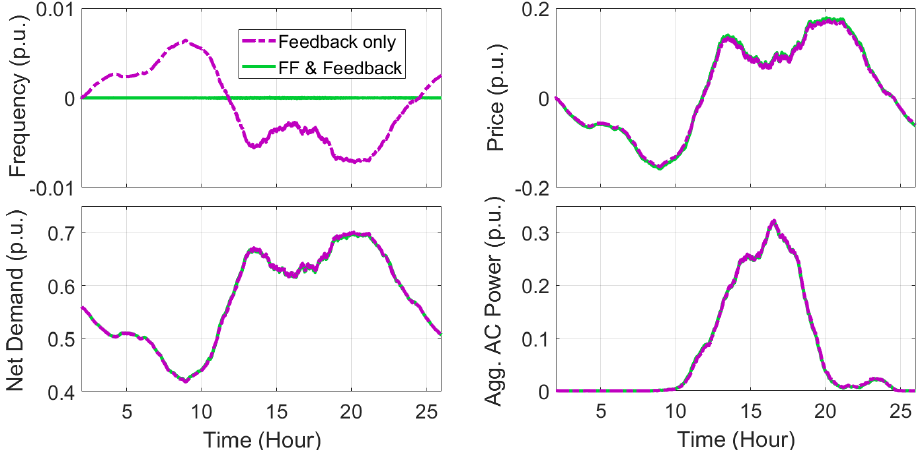
Figure 23. Transactive frequency control with feedforward price broadcast.